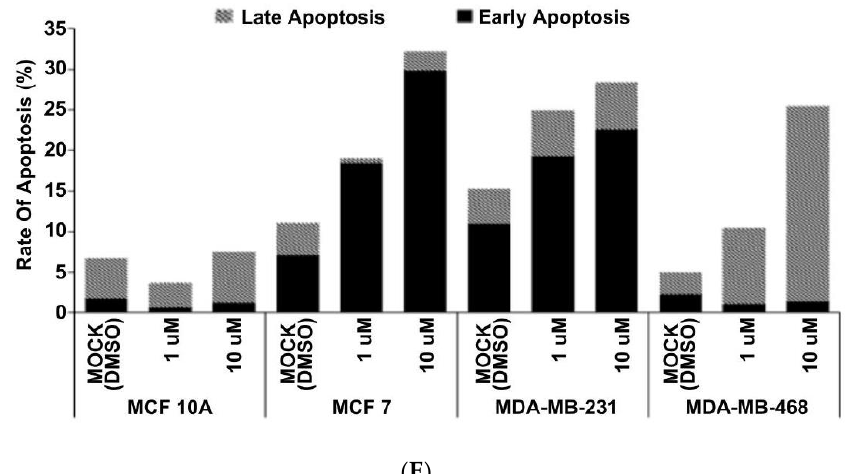
Figure 5. RSK3I inhibits tumorigenesis and increases apoptosis in breast cancer cells. ( A ) The basal expression levels of RSK3 and I κ B α in breast cancer and normal breast epithelial cell lines were analyzed using Western blots. Representative results from two experiments are shown. ( B ) Cell viability was analyzed using a CCK assay. RSK3I was added at concentrations of 0.1 µ M, 1 µ M, and 10 µ M for 24 h. ( C ) Foci assays were performed to analyze the growth of breast cancer cells (MCF7, MDA-MB-468, and MDA-MB231). Cells were incubated with RSK3I for 14 days and stained with 0.5% crystal violet. Cell counting was performed using the ImageJ (Java-based image processing program) tool. ( D ) Wound-healing assays were performed to analyze the effect of RSK3I on the migration of MDA-MB-231 cells. The cells were treated with several concentrations (0.1 µ M, 1 µ M, and 10 µ M) of RSK3I, and cell migration was monitored for 48 h. ( E ) The effect of RSKI on apoptosis was assessed by Annexin V/PI staining followed by flow cytometry analysis. RSK3I was added to breast cancer cells (MCF7, MDA-MB-468, and MDA-MB-231) or a normal breast epithelial cell (MCF10A) at concentrations of 1 µ M and 10 µ M for 24 h, and DMSO was used as a